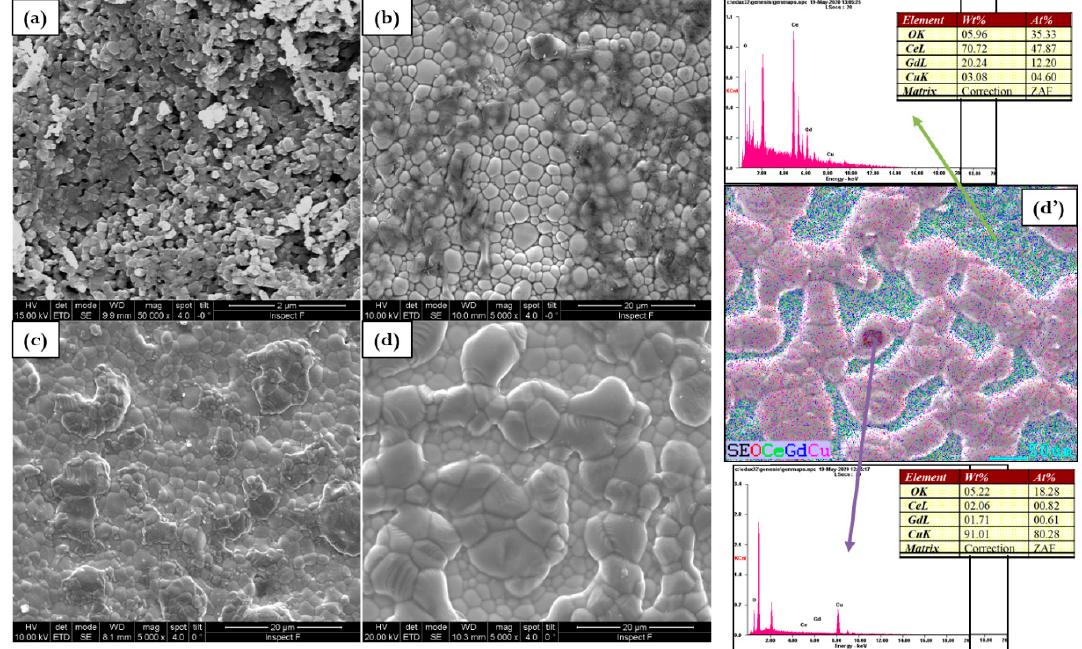
Figure 5. Microstructure evolution for ( a ) GDC, ( b ) 0.5 Cu, ( c ) 1 Cu, ( d ) 2 Cu, and ( d’ ) EDX mapping of 2 Cu (d’) sintered at 1100 °C.